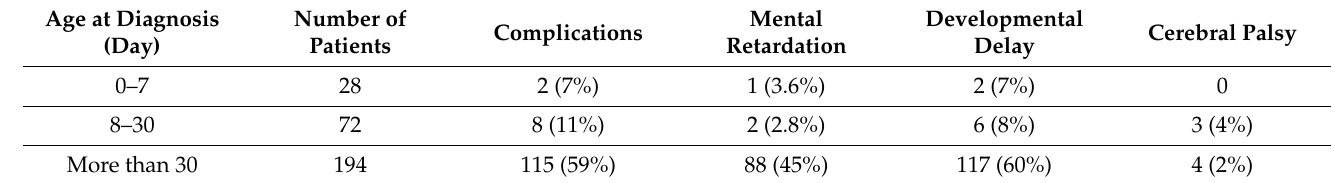
Table 4. Effect of age of diagnosis on the incidence of complications from